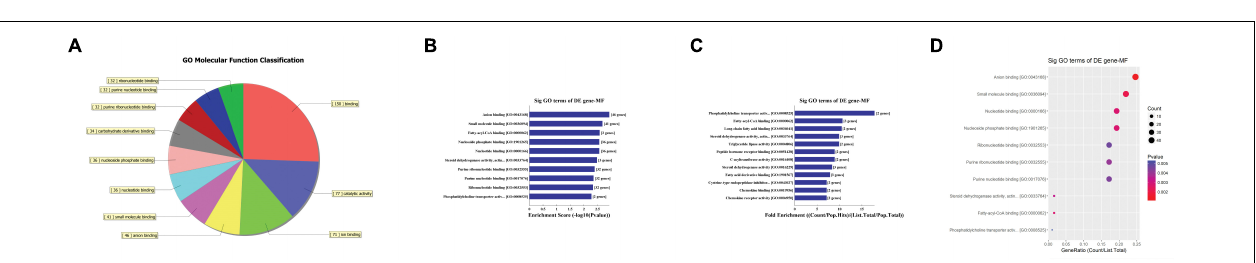
FIGURE 7 | The GO annotations for molecular function of target mRNAs regulated by the five candidate circRNAs. (A) The pie chart above shows the top 10 counts of the significant enrichment terms. (B) The bar plot shows the top 10 enrichment score values of the significant enrichment terms. (C) The bar plot shows the top 10-fold enrichment values of the significant enrichment terms. (D) The dot plot shows the gene ratio values of the top 10 most significant enrichment terms. Gene ratio: the GOID’s gene ratio value, which equals